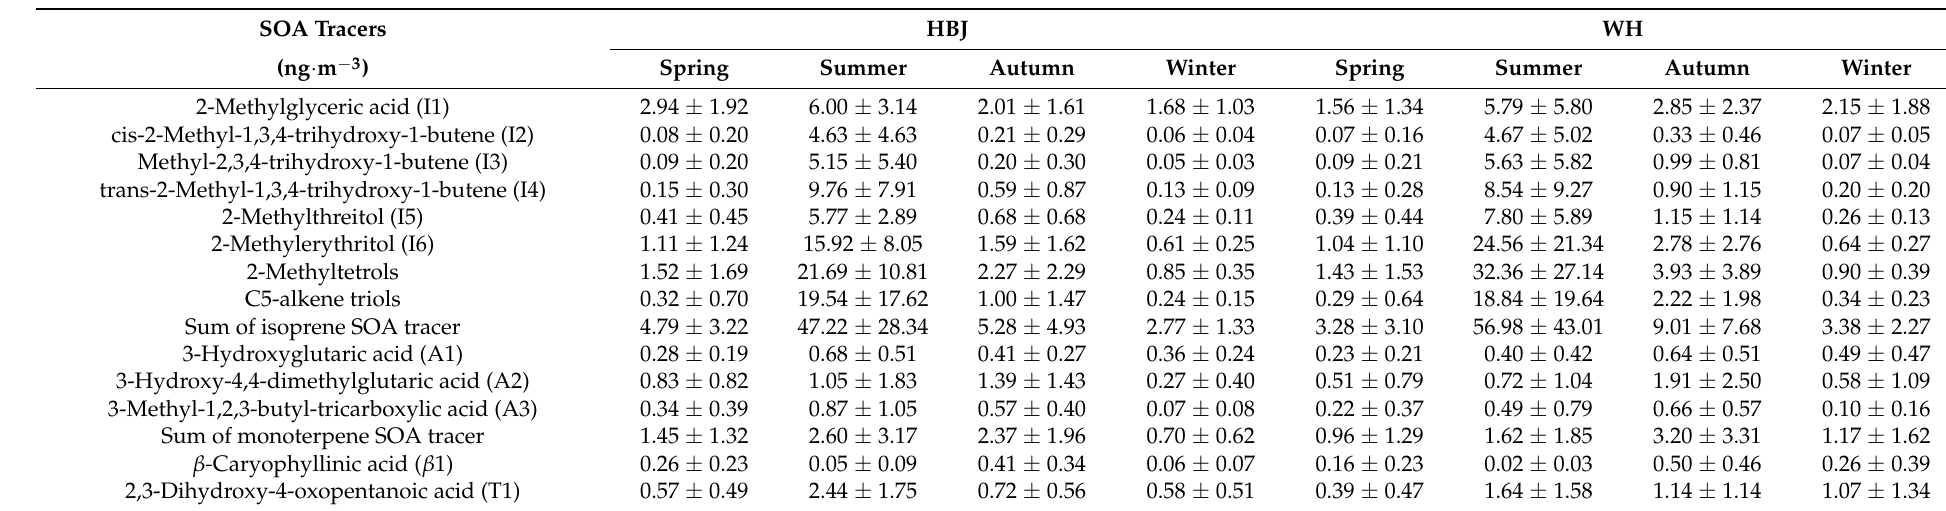
Table 2. Concentrations of SOA tracers in PM 2.5 in